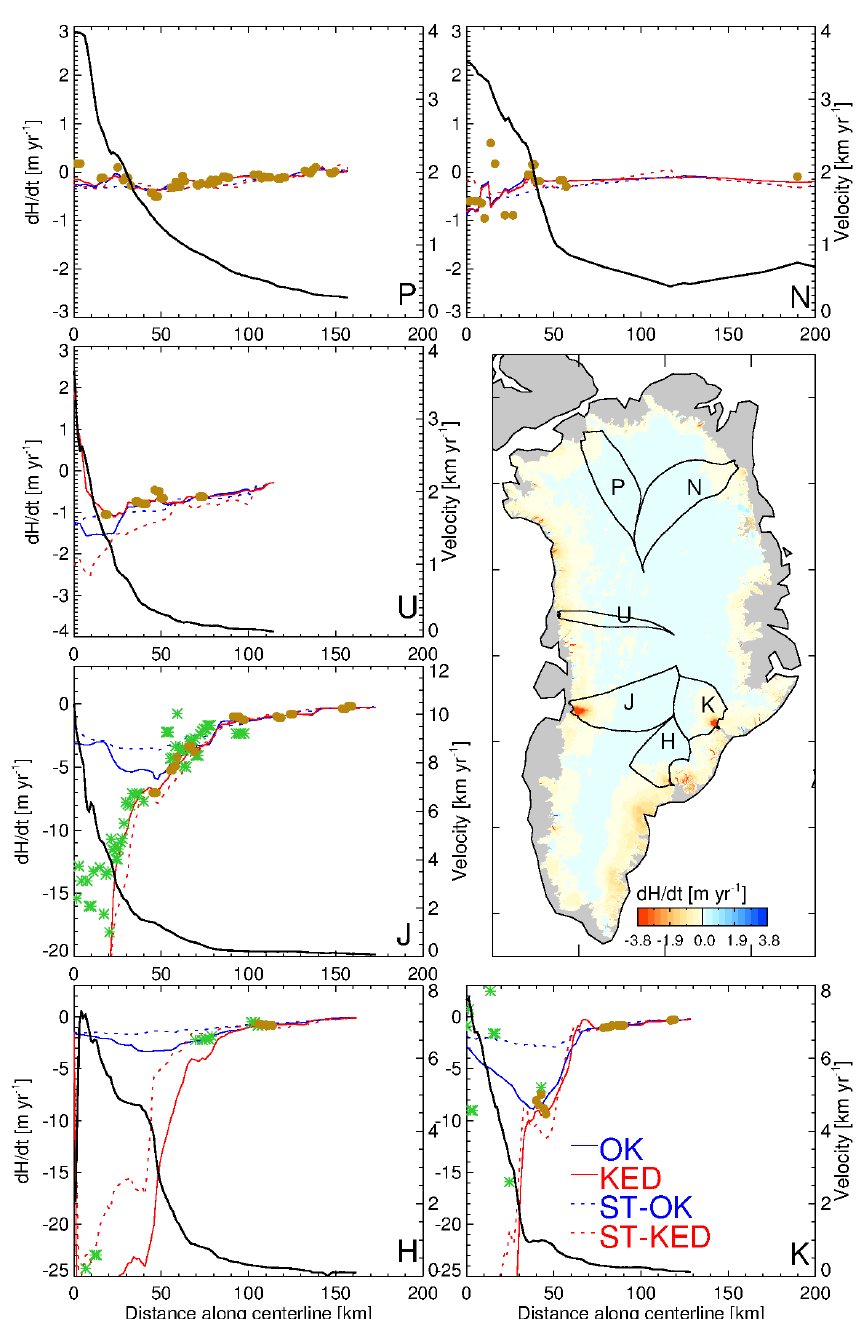
Figure 3. Interpolation results for selected test basins and averaged ICESat data (2003–2009). The map shows interpolated elevation change rates using ST-KED for the entire GrIS and the outline of six selected glaciers. The remaining plots show elevation change rate and velocity along a transect following the centreline of each glacier. In addition, ICESat points (brown) and ATM measurements (green stars) along the transect are shown. Note that the ATM data were not used in the regression. Surface velocity along the flowline is shown by the solid black